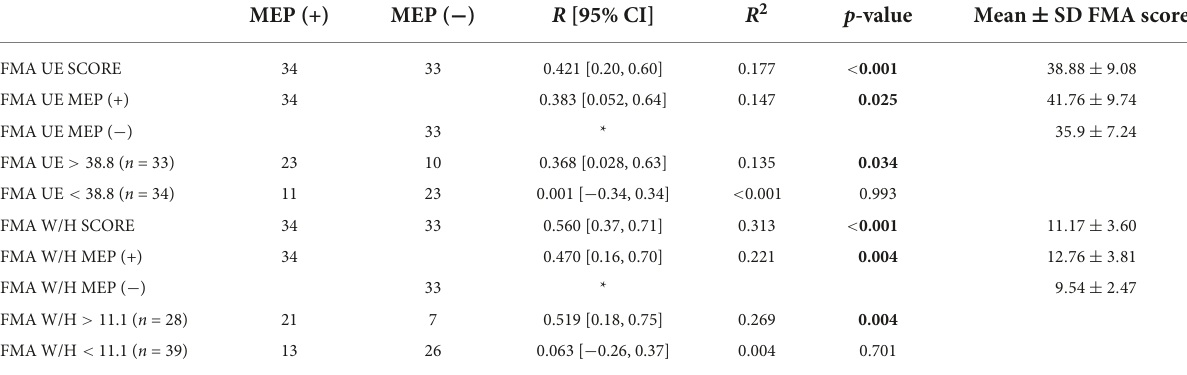
TABLE 3 Relationship between FMA UE scores and FMA W/H scores with